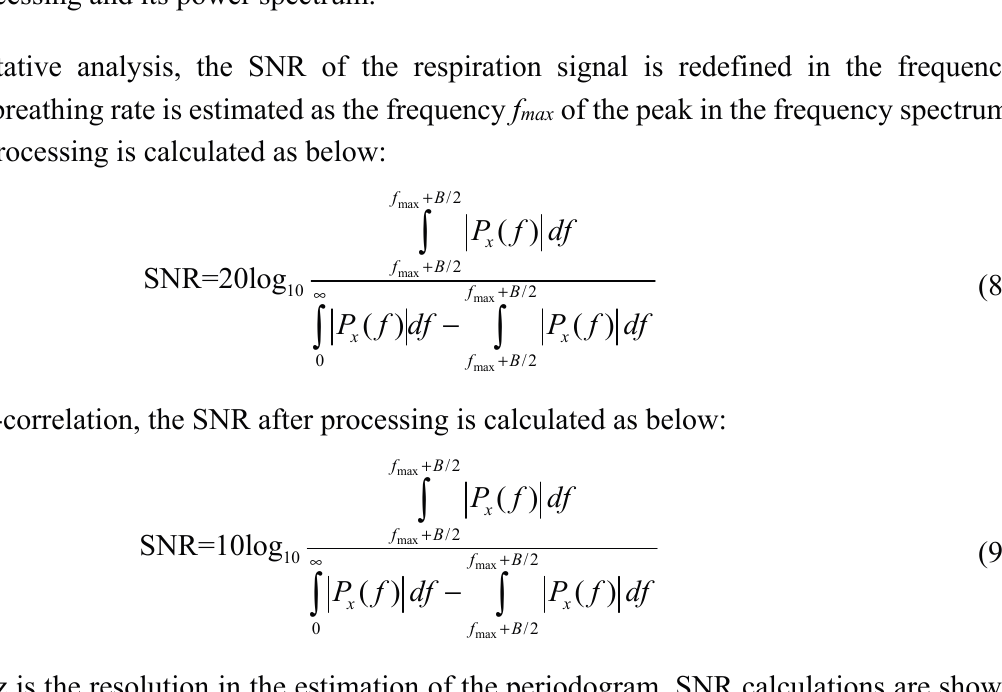
Figure 12. Signals collected in a strong interference environment when the radar is 7 m away from the human body. ( a ) Original signal waveform and its frequency spectrum; ( b ) Signal after the processing and its power